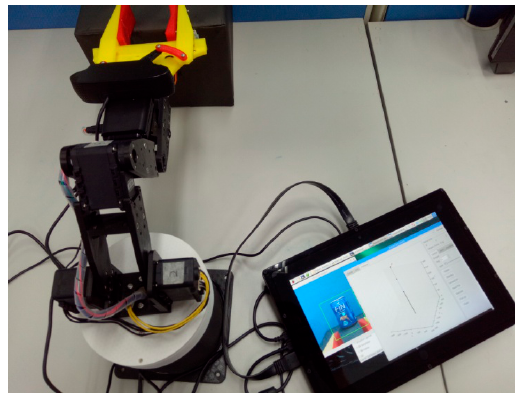
Figure 13. The robotic arm GUI in the Raspberry Pi via a 10-inch touch-screen tablet computer.